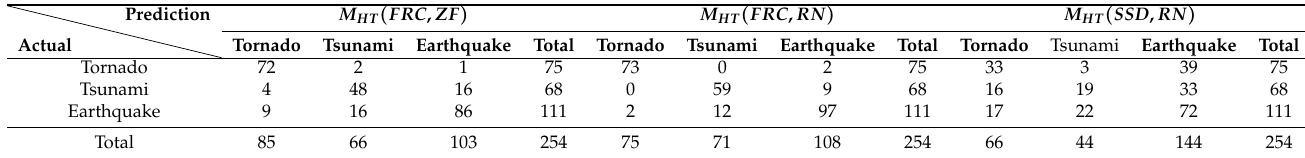
Table 2. Confusion matrix of hazard-type prediction.